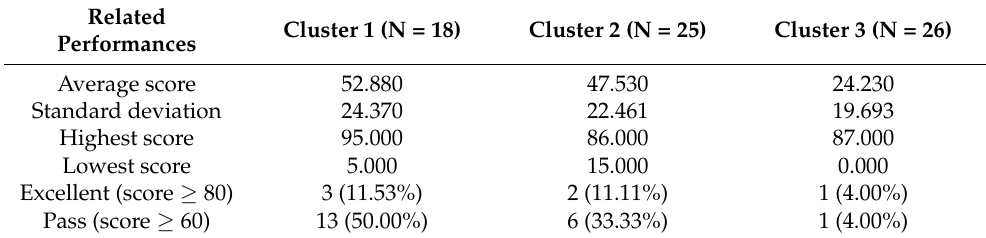
Table 5. Distribution of academic